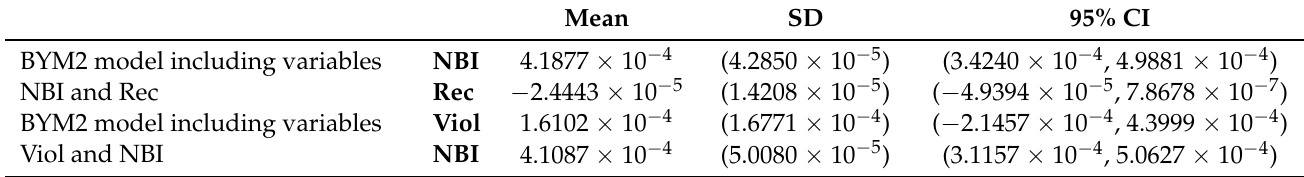
Table 12. Marginal effects at the means for some of the BYM2 models fitted in INLA to the Colombia infant mortality rates data set.